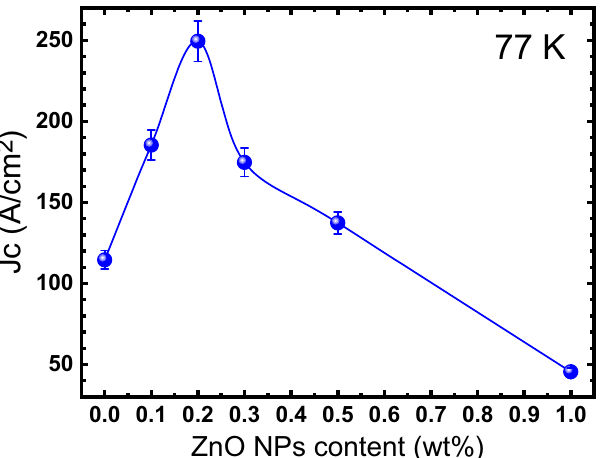
Figure 5. Variations of the measured critical current density, at 77 K , with respect to the ZnO NPs